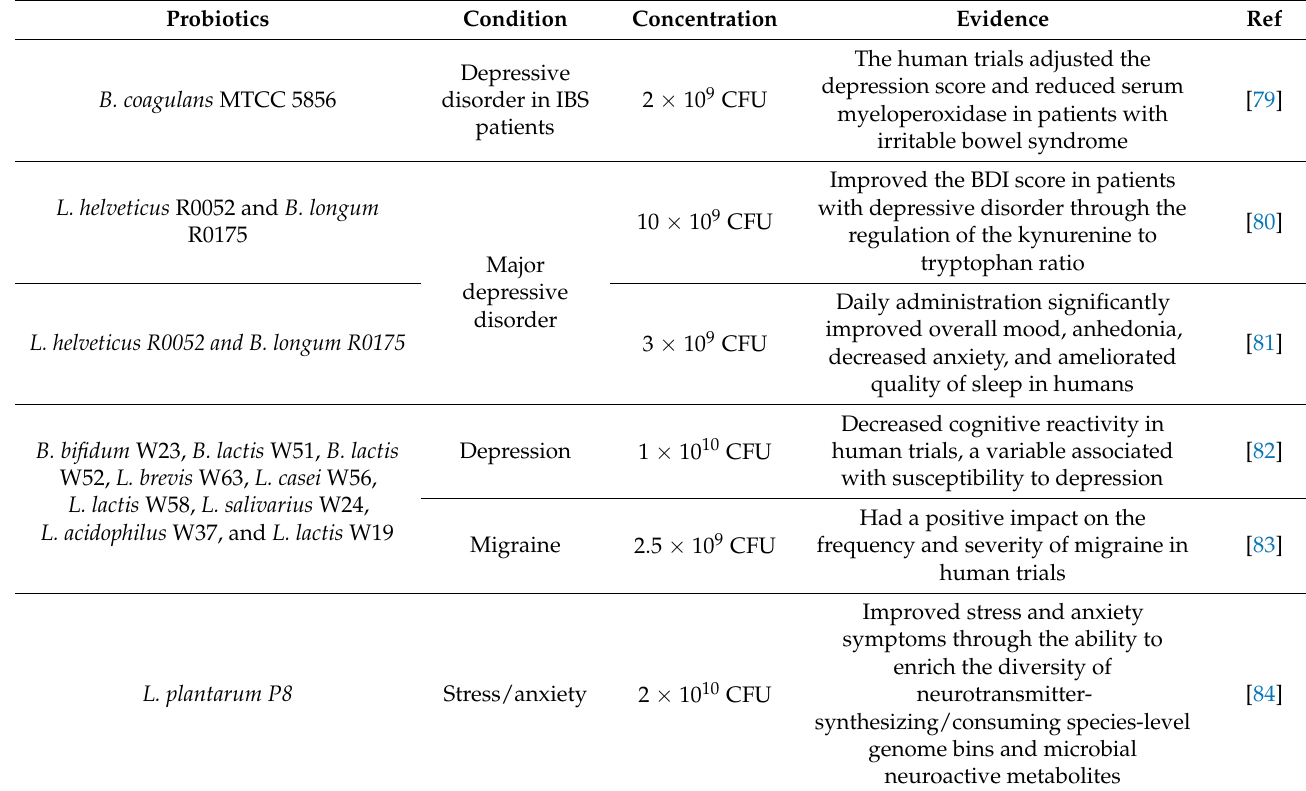
Table 4. Probiotics associated with the management of neurological